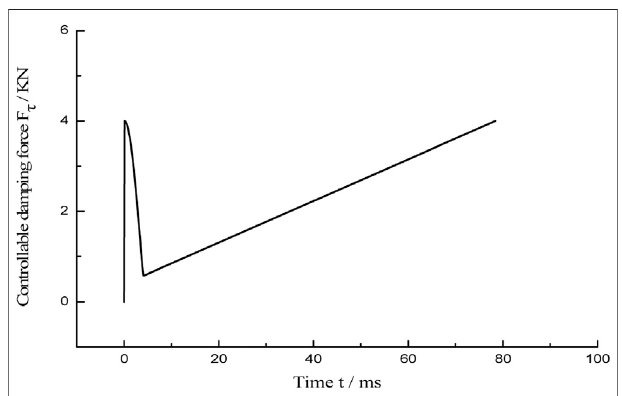
FIGURE 4 | Ideal curve of controllable damping force F τ _i .